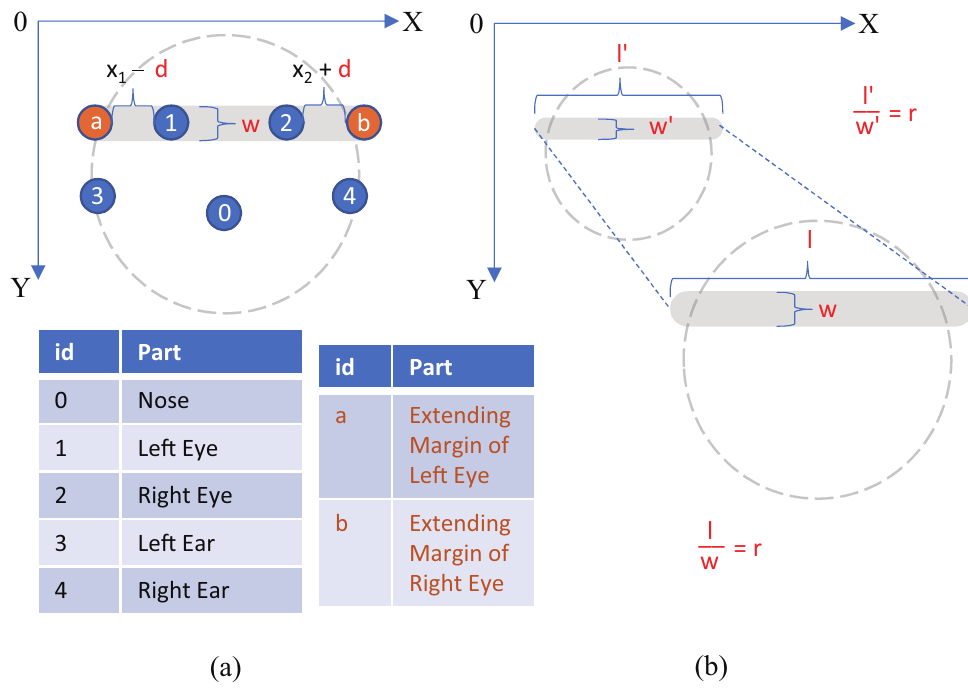
Figure 4. The proposed two concepts for designing algorithm: ( a ) Eye mosaic utilizing eye coordinates. ( b ) Eye line mosaic of face with distance